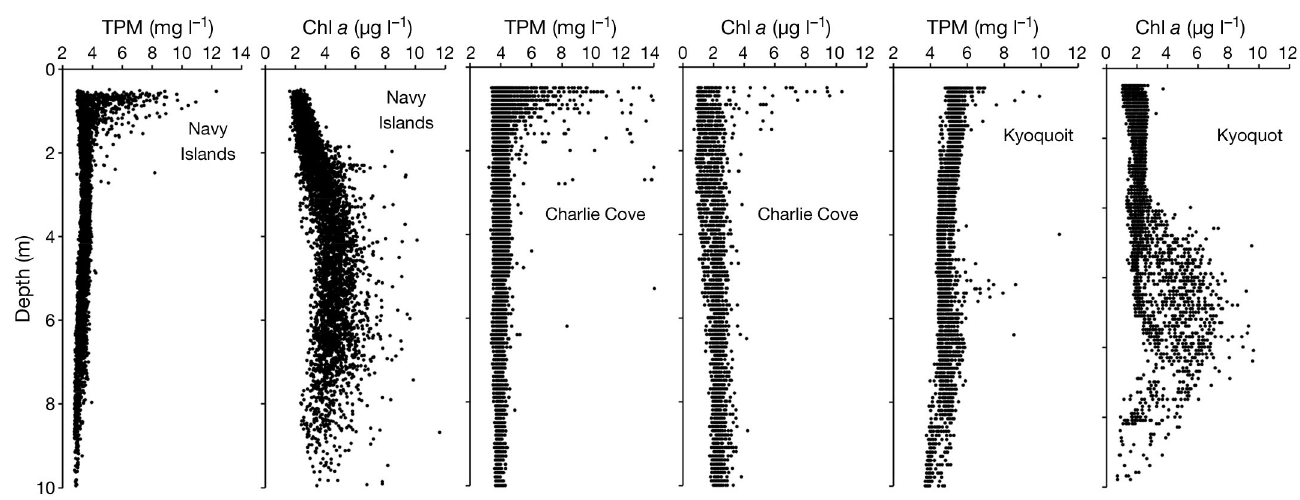
Fig. 6. Depth profile plots of total suspended particulate matter (TPM; mg l −1 ) and chlorophyll a (chl a ; µg l −1 ) concentrations measured at the Navy Island salmon farm on 16 June 2010 (n = 5252), at the Charlie Cove salmon farm between 5 and 7 July 2011 (n = 13690), and at the Kyuquot Sound sablefish farm on 26 July 2011 (n = 6082)